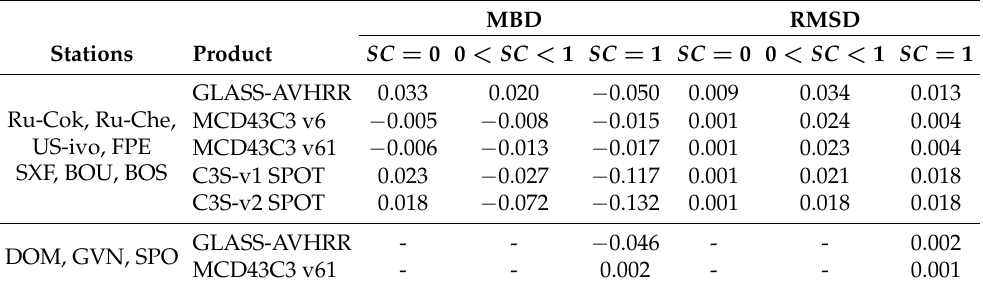
Table 4. Summary metrics (median MBD and median RMSD) of the different products from 2000/02 to 2014/05 at the stations where all products are simultaneously available (Ru-Cok, Ru-Che, US-Ivo, FPE, SXF, BOU, BOS) and at Antarctic stations (DOM, GVN,